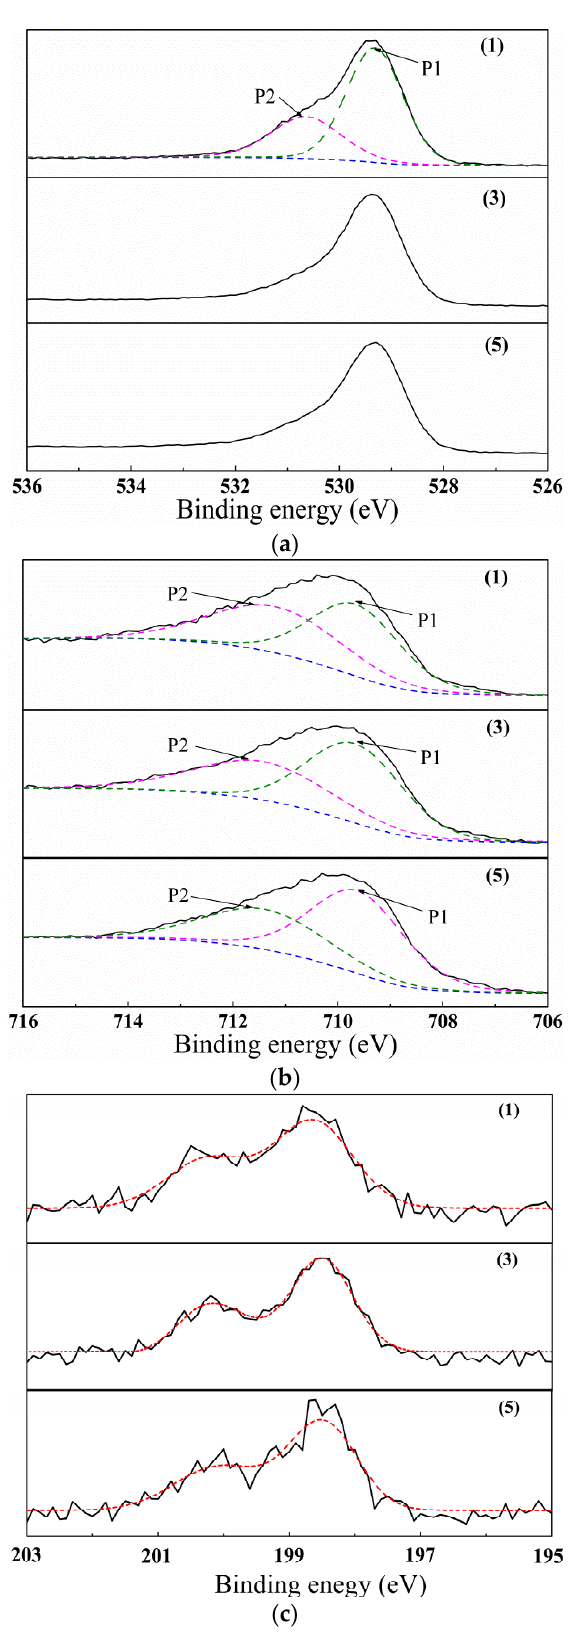
Figure 5. XPS spectra of samples (1), (3), and (5), representing O ls ( a ) Fe 2p 3/2 ( b ) and Cl 2p ( c ) line regions.